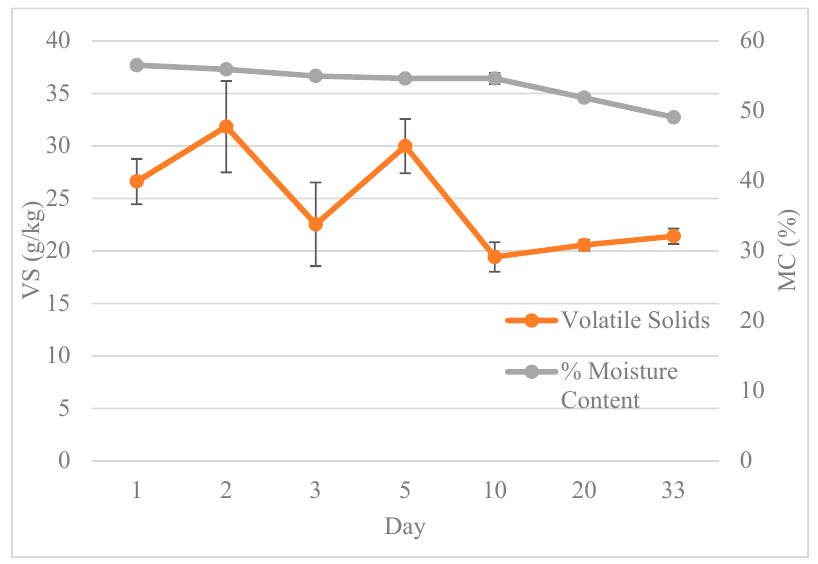
Figure 3. Average volatile solid (VS) concentrations (g/kg) and moisture content (MC) (%) during composting of sick cow bedding from a 1000 cow dairy farm.